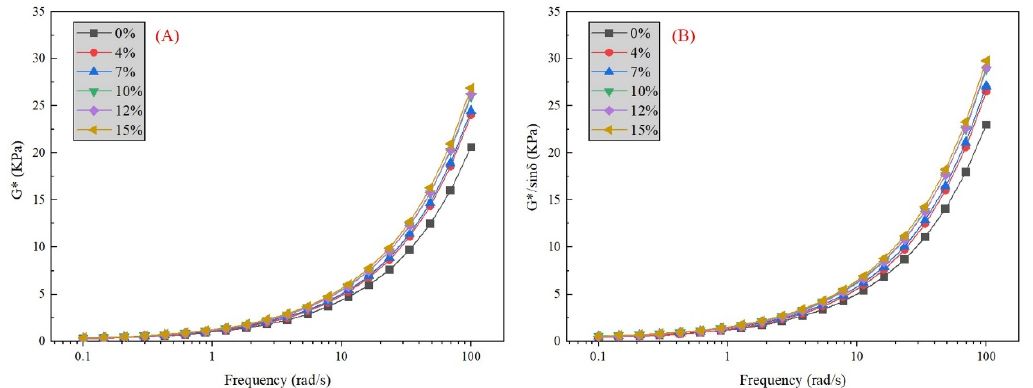
Figure 10. Different parameters varying with frequency: ( A ) composite shear modulus G*; ( B ) rutting factor G*/sin δ .